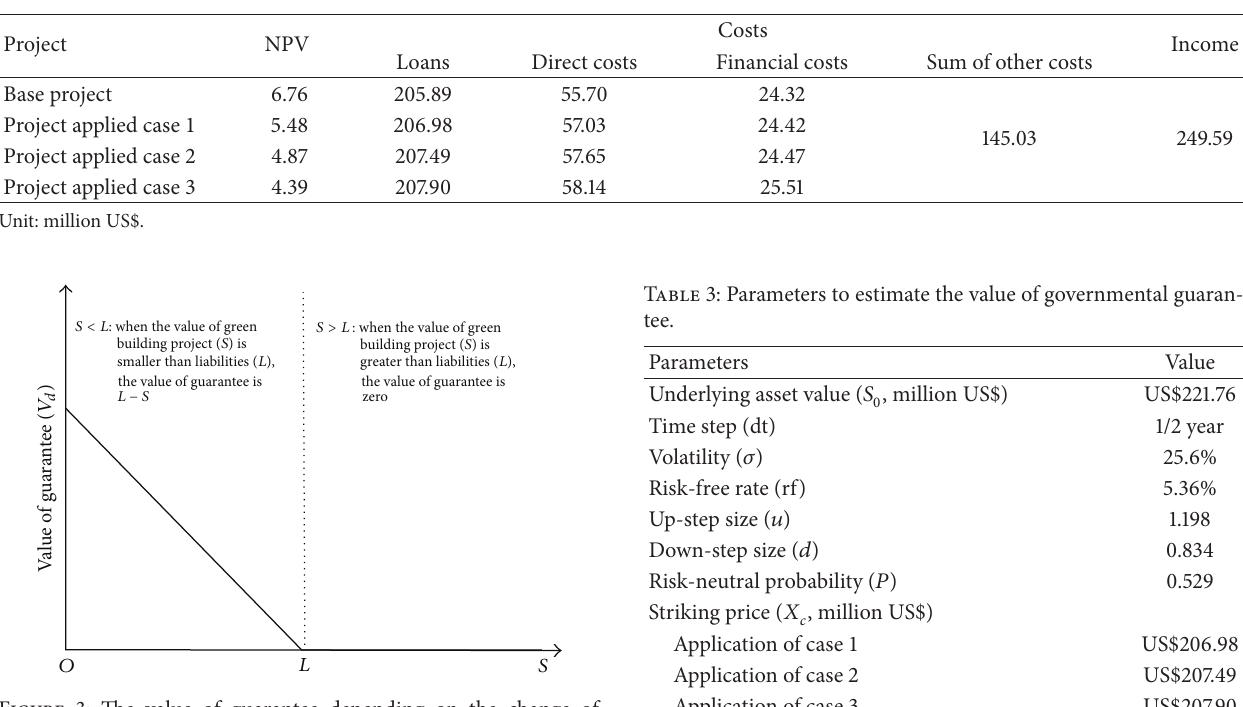
Figure 3: The value of guarantee depending on the change of a project value.